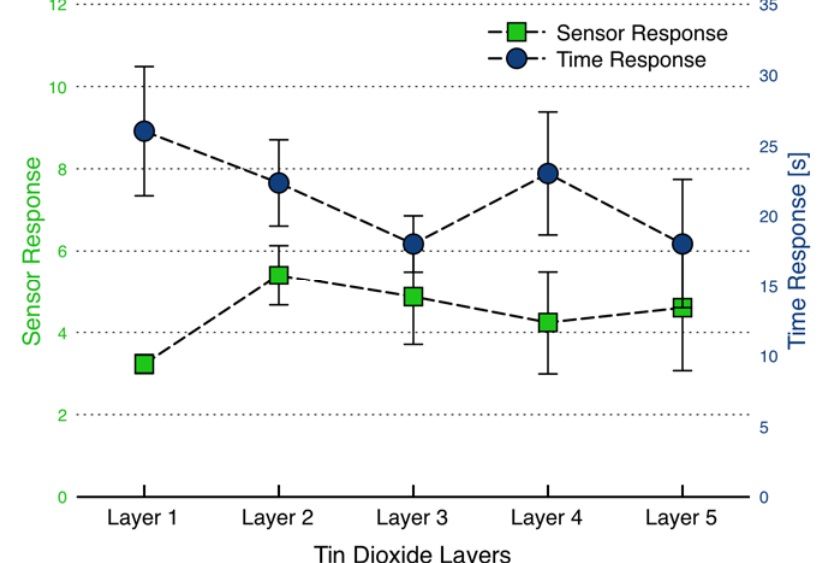
Figure 12. Sensor performance as a function of deposition layer using the dispersion-drop method. Each deposition step was followed by a 500 ºC annealing step for 1.5 hrs. The error bars represent standard deviations associated with three tests conducted after each deposition on an individual